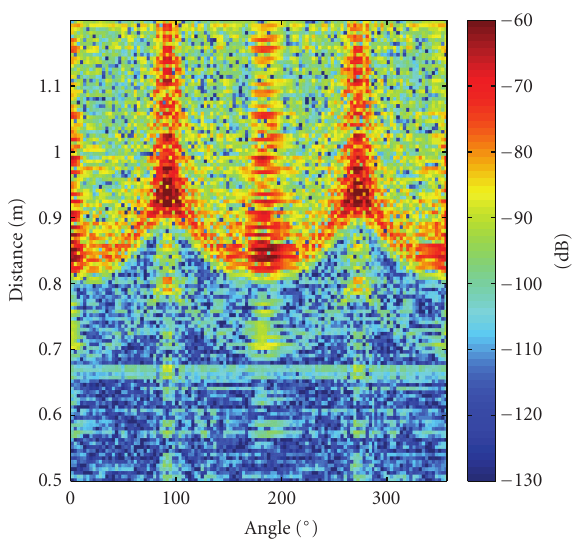
Figure 4: Radargram of a simulated rectangle object (30cm by 12cm).